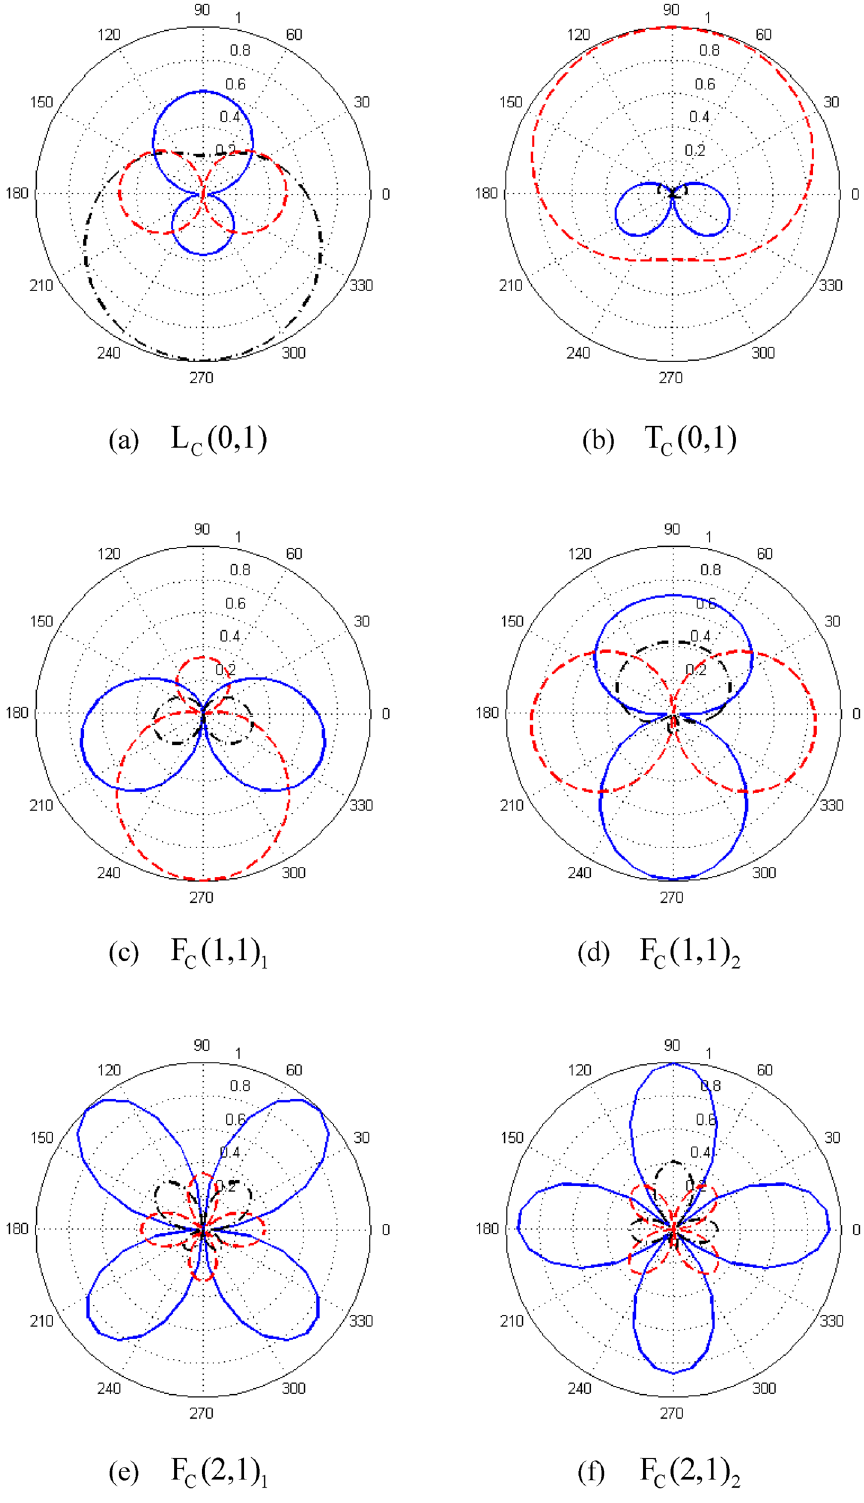
Figure 3. Displacement distributions along circumferential direction (the blue solid, red dotted, and black dashed-dotted lines show the displacements in the radial, circumferential, and axial directions,